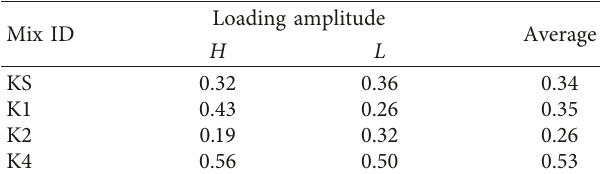
Figure 8: Damage characteristic curves of (a) KS, (b) K1, (c) K2, and (d) K4 mixtures. Table 5: C ∗ values at failure ( C ) from cyclic fatigue test. f